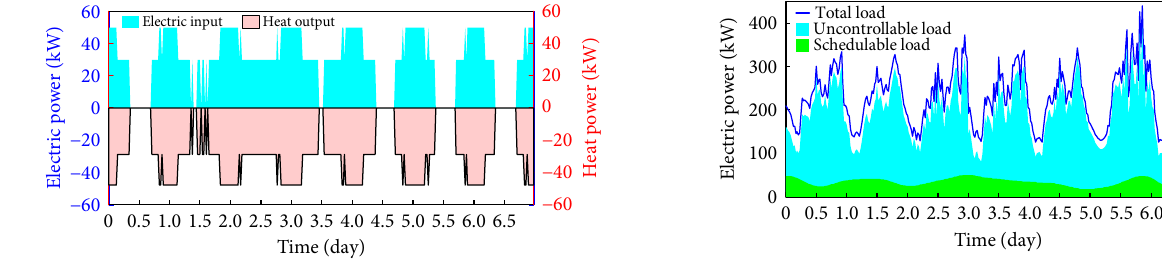
Fig. 12 Generated operating characteristics of EB. Fig. 13 Generated loads waveform involving uncontrollable and shcedulable